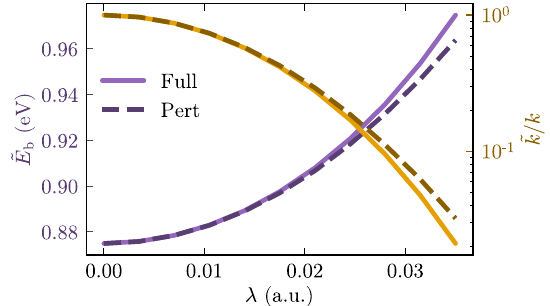
FIG. 4. Cavity Born-Oppenheimer energy barrier (purple lines) and relative change of reaction rates (yellow lines) for the Shin- Metiu model inside a cavity, calculated to all orders in the light- matter coupling strength λ (solid lines) and up to second order in perturbation theory (dashed